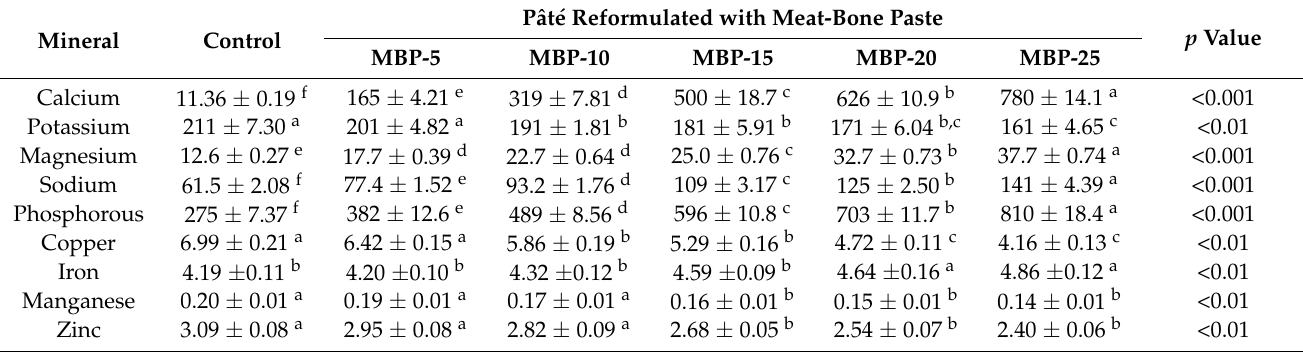
Table 5. Mineral composition (expressed as mg/100 g) of liver p â t é s with meat-bone paste. Mineral